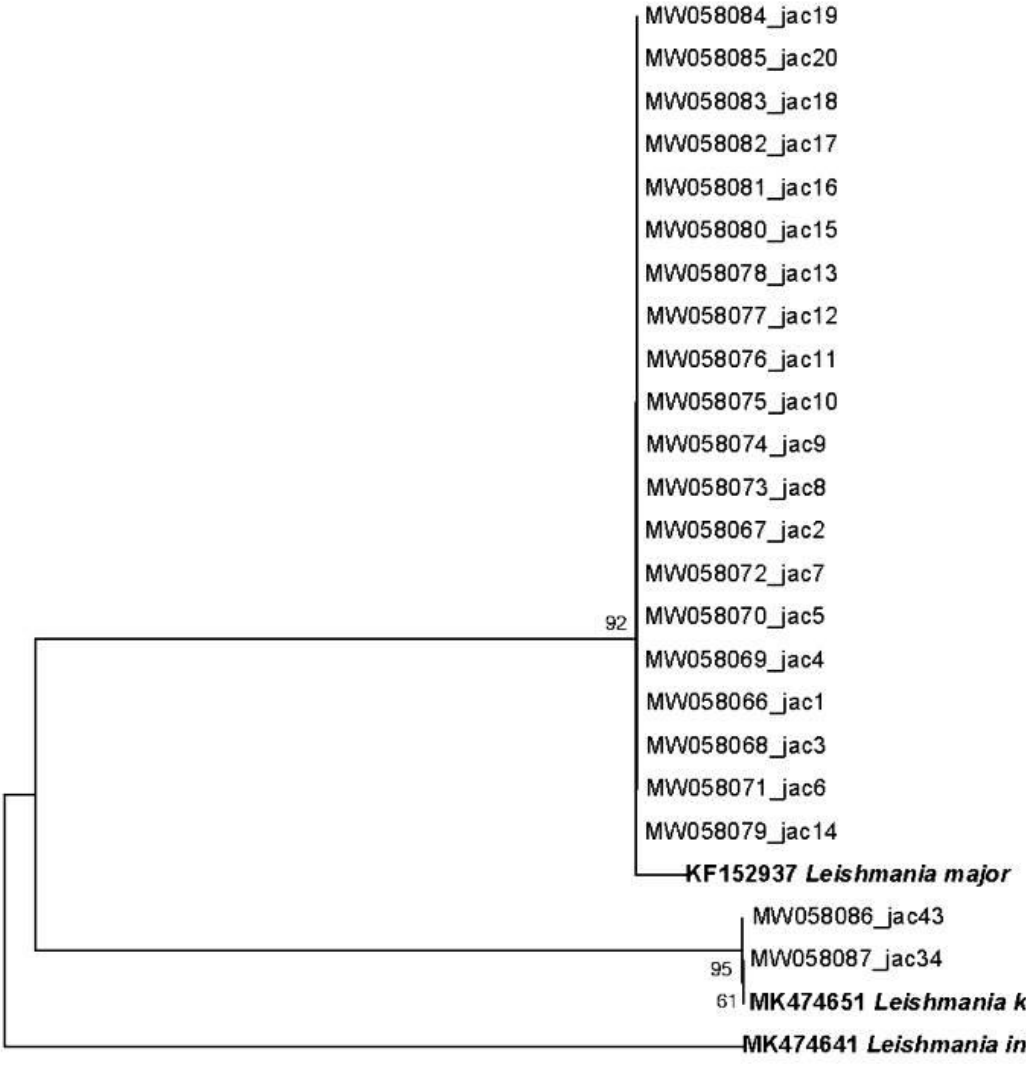
Figure 4. Maximum likelihood phylogenetic tree constructed with Leishmania ITS1 sequences detected among Jaculus species and three sequences used as references (bold-faced). The numbers above each sequence are their accession numbers, and those above the branches are bootstrap percentages of 1000 replications.